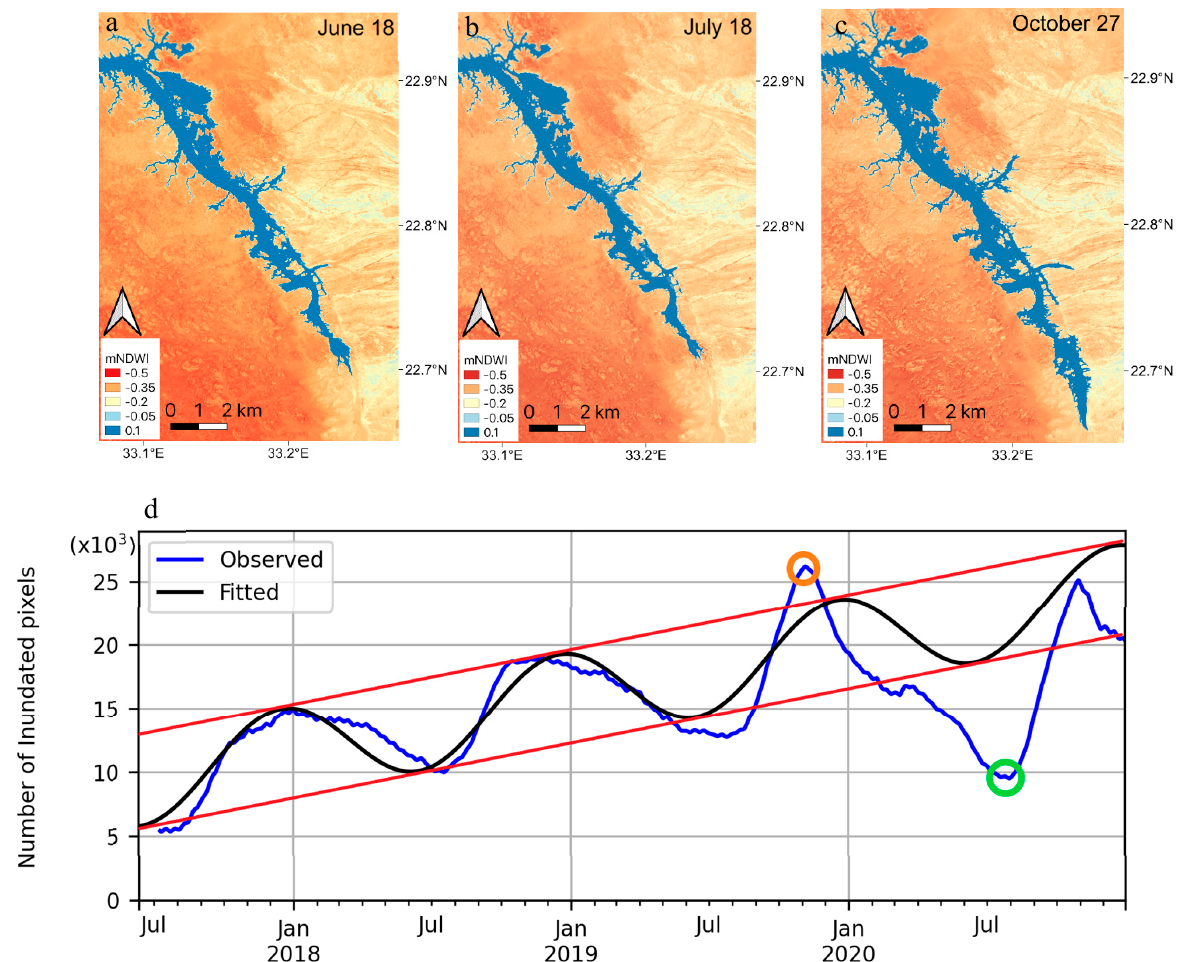
Figure 5. ( a – d ) Selected regions of Lake Nasser. Image retrieved from Sentinel-1 and processed to classify water and land pixels using mNDWI. Figure ( d ) shows the water areas represented by pixel counts for the region. Please note that the orange and green circles denote anomalous events. In 2019, Sudan suffered from floods, which impacted the inundated pixels at Lake Nasser. On the other hand, in July 2020, the impact of GERD filling can be seen by the low values of water inundated pixels. The water area in “d” is for a rectangular region with a latitudinal extent of (22.655 ◦ N, 22.790 ◦ N) and longitudinal extent of (33.169 ◦ E, 33.265 ◦